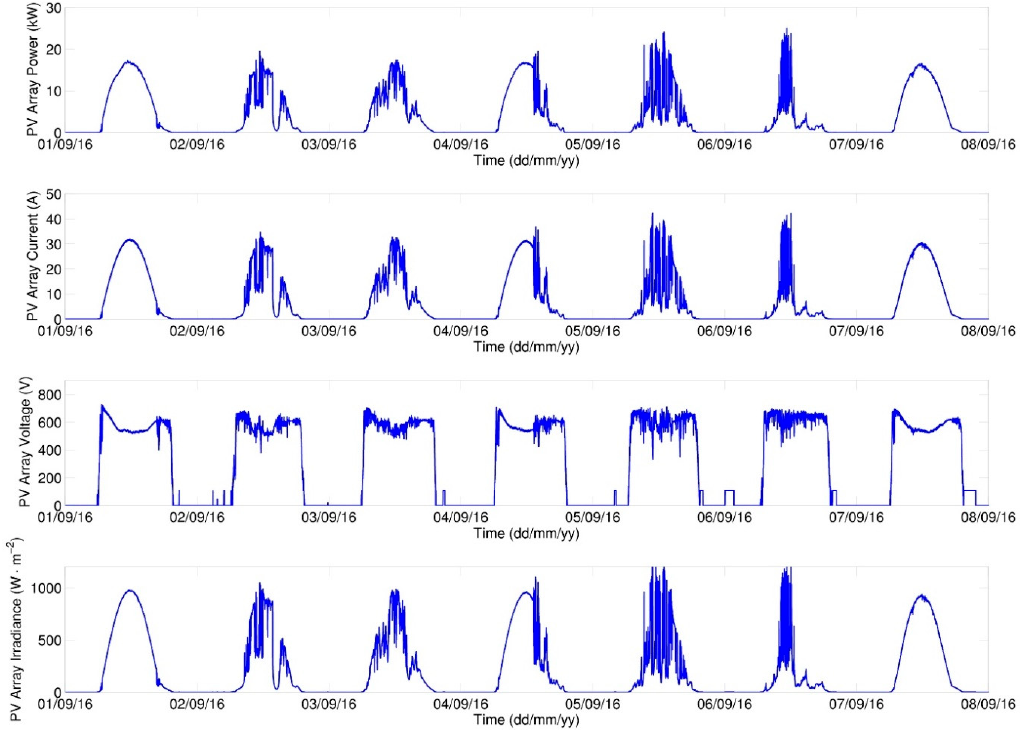
Figure 21. Resulting profiles for simulation of operating states of PVS, scenario B.